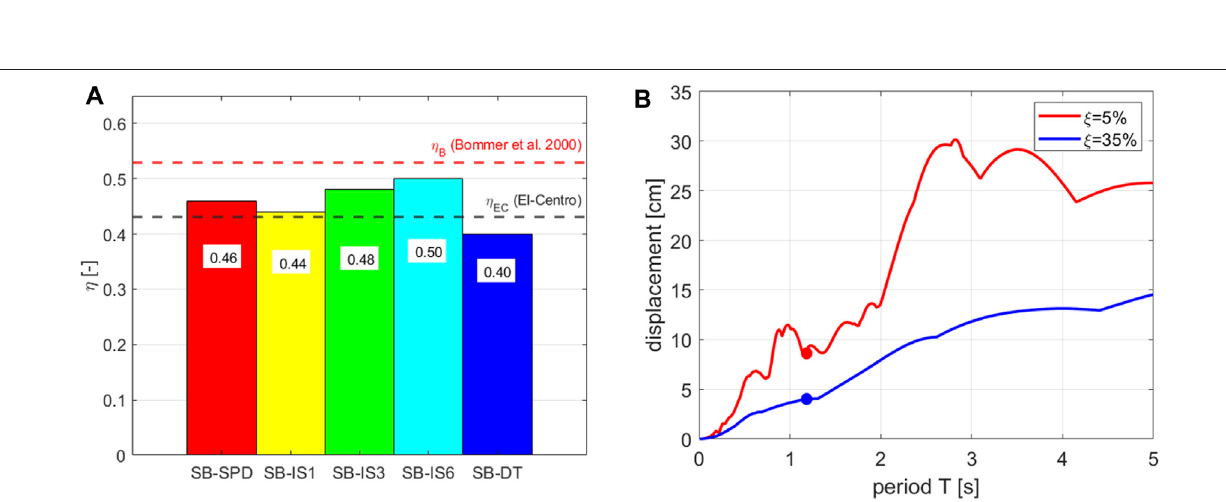
Frontiers in Built Environment |